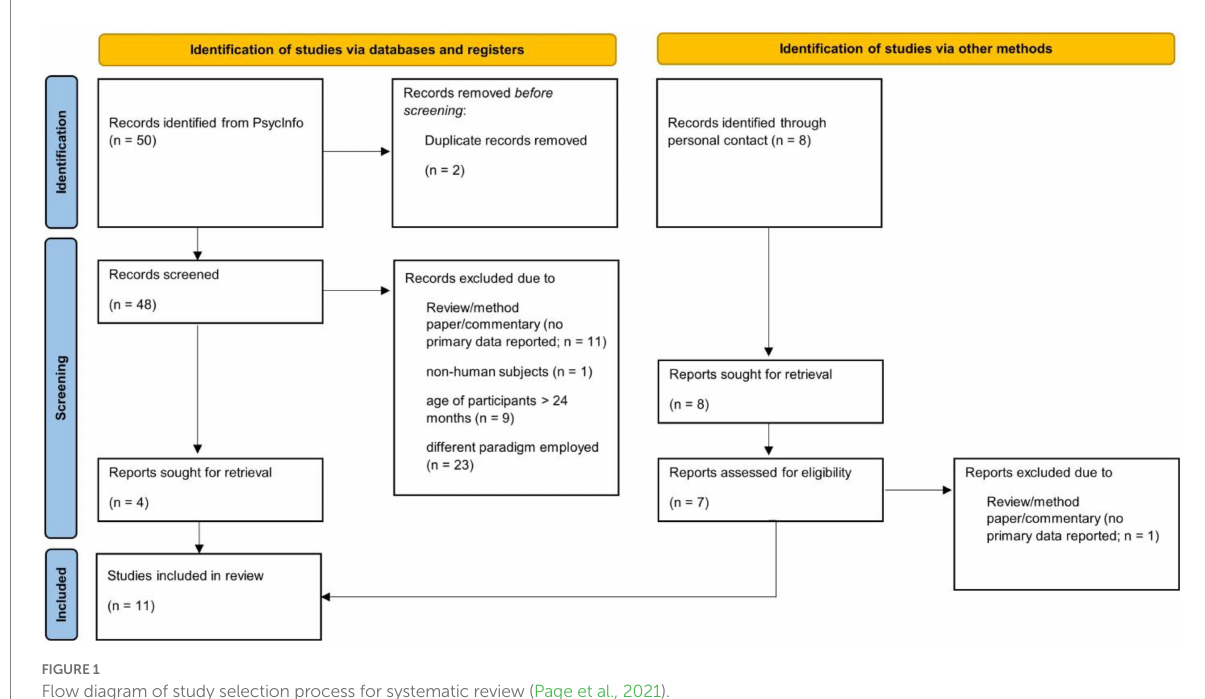
FIGURE 1 Flow diagram of study selection process for systematic review (Page et al., 2021).